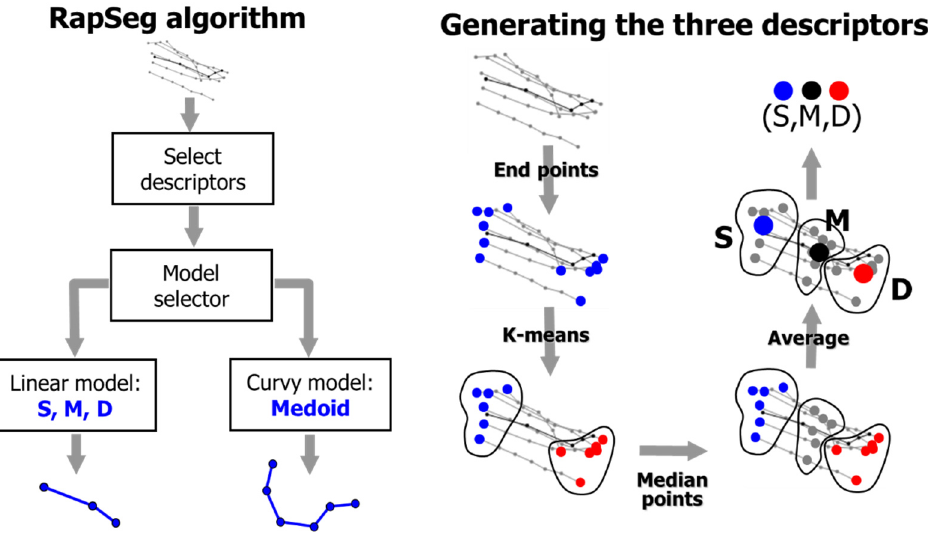
Figure 5. Overall structure of the RapSeg algorithm [32] and the creation of the three descriptors.